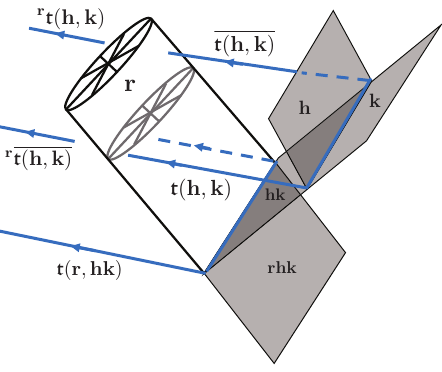
Figure 10: Fusion of three defect sheets, r , h , k , where r is a spatial reflection symme- try. As the anyon lines cross the crosscap sheet associated with r , they get reflected in space in addition to being permuted by the action of (cid:26)